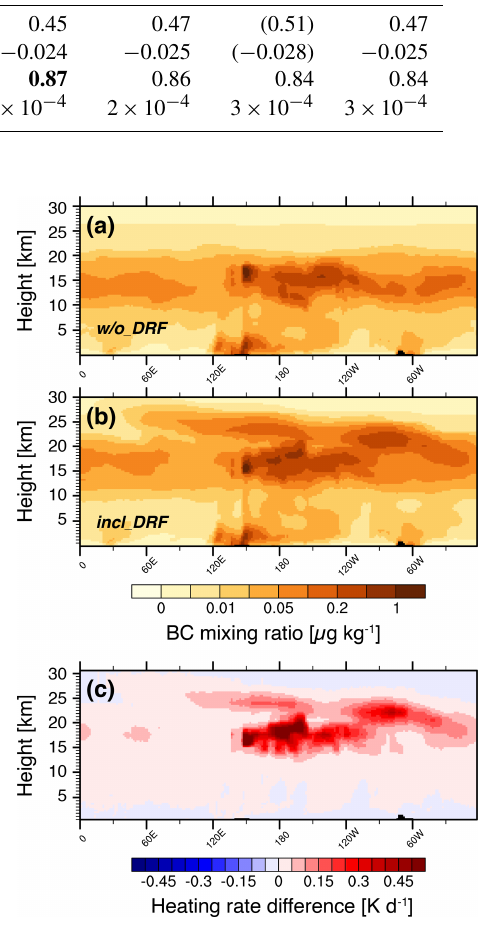
Figure 6. Longitude-height distributions of modeled black carbon (BC) mixing ratios at latitude of 35 ◦ S on average for January 2020 for the case TP1_8020 (a) without ( w/o_DRF ) and (b) including direct aerosol radiative forcing ( incl_DRF ). (c) Change in monthly mean short-wave heating rate caused by the absorption of solar radi- ation by the Australian wildfire smoke from the pyroCb days, com- puted as the difference between the cases TP1_8020 and NoEmiss